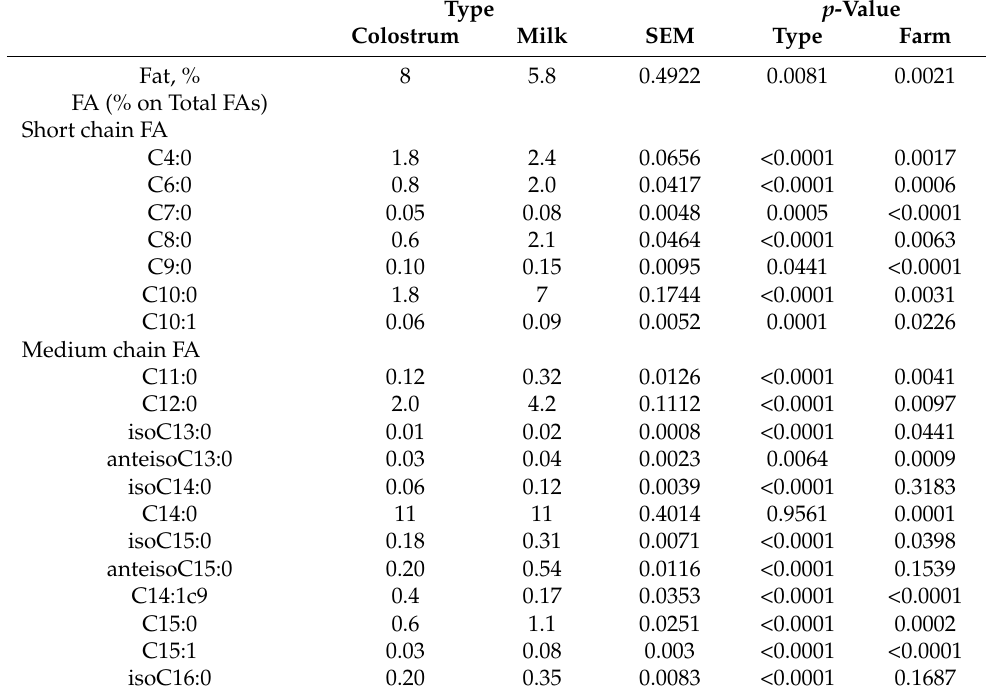
Table 4. Fat content and fatty acid profile of colostrum (% on the total of FAs) and mature milk sampled in eight